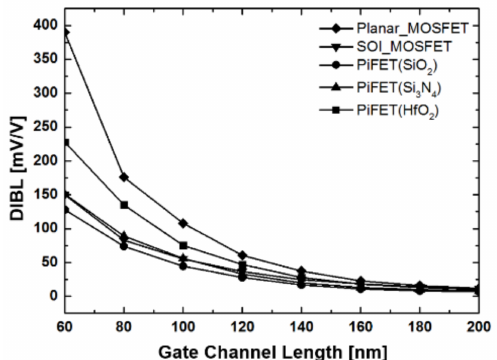
Figure 9. Simulation results of the DIBL characteristic of planar MOSFET, SOI MOSFET, and PiFETs, each with a silicon film thickness of 15 nm, as well as the buried insulators of the SiO 2 , Si 3 N 4 , and HfO 2